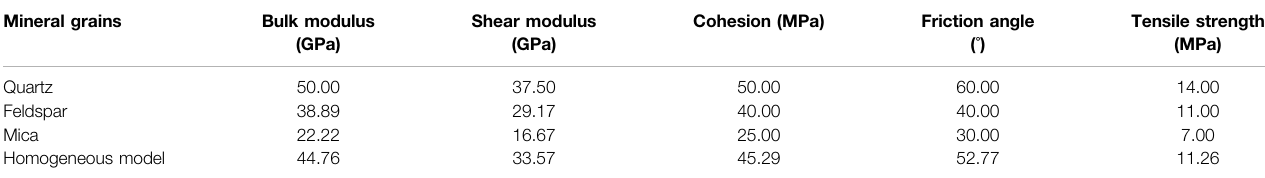
TABLE 1 | Physical parameters of different minerals (revised from Chen et al., 2004).